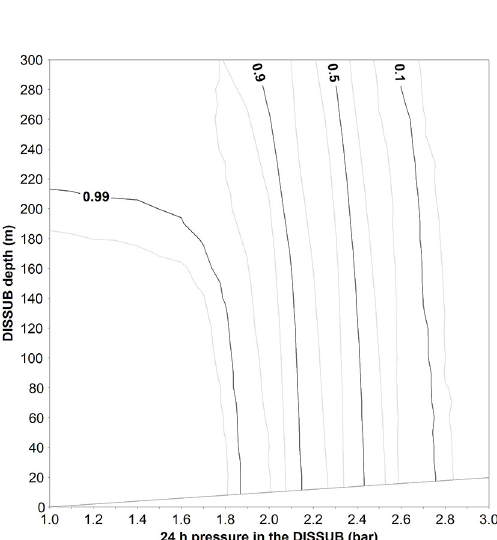
Figure 1. Probability of survival curves for an 80kg individual for escape following 24h at raised DISSUB pressure